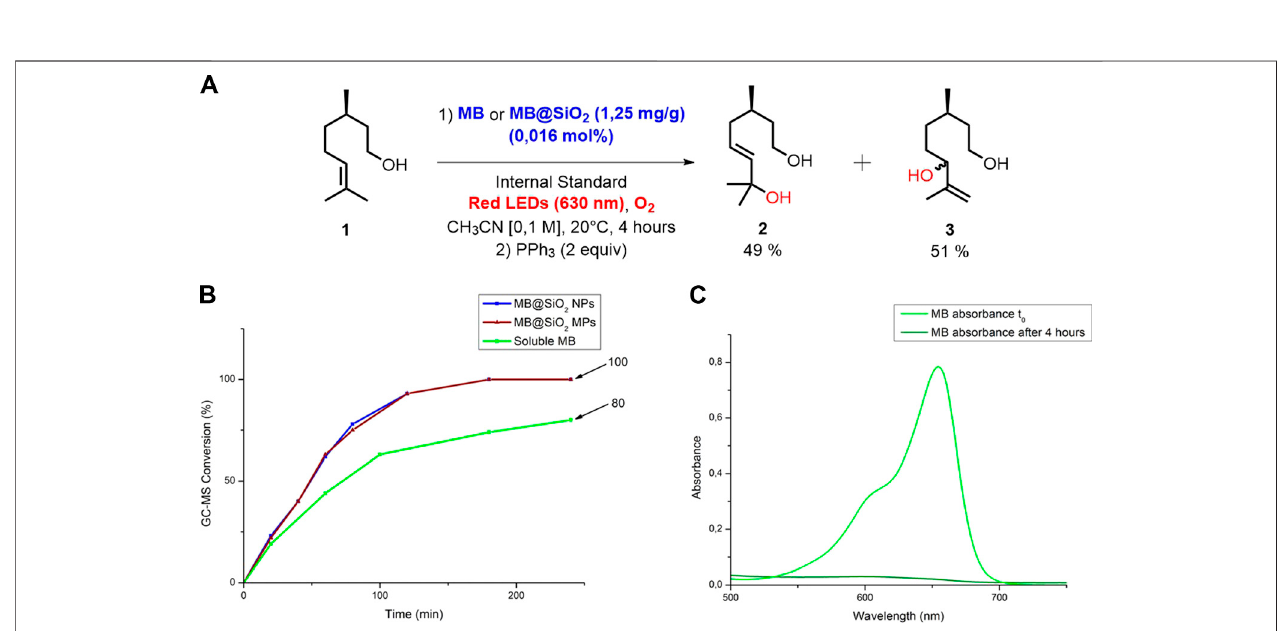
FIGURE 2 | (A) Photooxidation of 1 using MB or MB/SiO 2 as a PC under red light irradiation (630 nm) (B) Monitoring of the conversion of 1 to 2 and 3 in a batch reactor, in function of time by GC-MS analysis (Internal Standard (cid:1) 1,3-dimethoxybenzene). The ratio between 2 and 3 is measured by 1 H NMR spectroscopy. (C) Absorption spectra of the homogeneous reaction media obtained at t 0 and after 4 h of